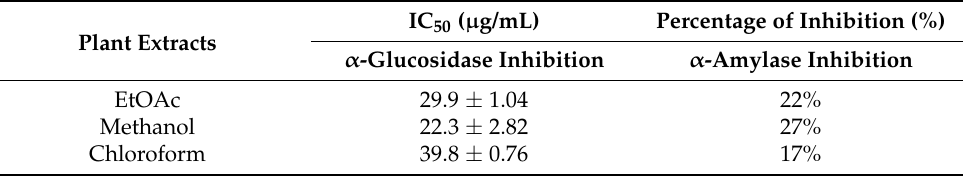
Table 3. Digestive enzymes inhibition activity ( α -glucosidase and α -amylase) of I. viscosa extracts expressed in IC 50 and percentage of inhibition (%). Data are expressed as mean ± SD ( n =